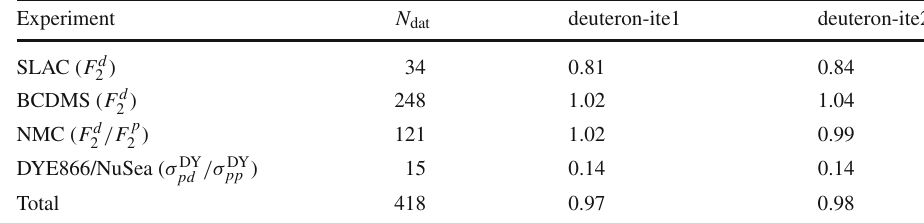
Table 2 The values of the χ 2 per data point for each dataset included in the fits of deuteron